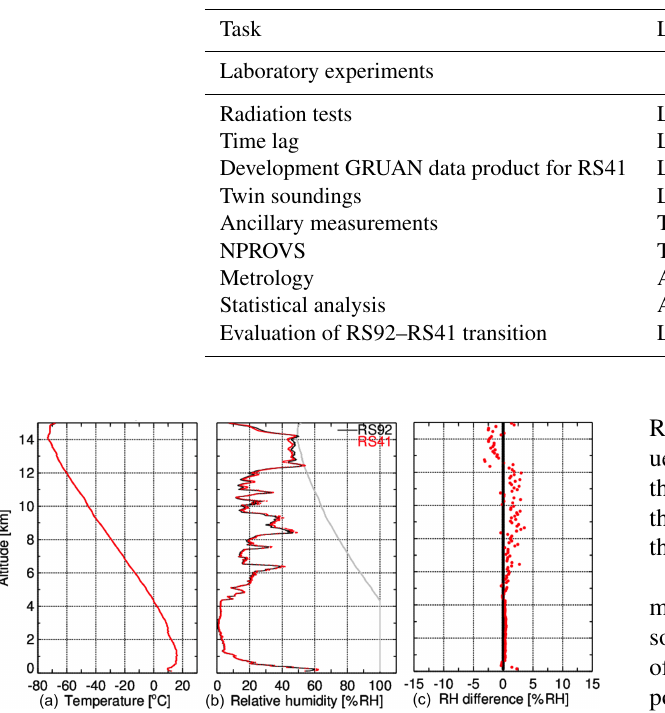
Table 5. List of scientific analysis tasks with their corresponding lead investigator(s).